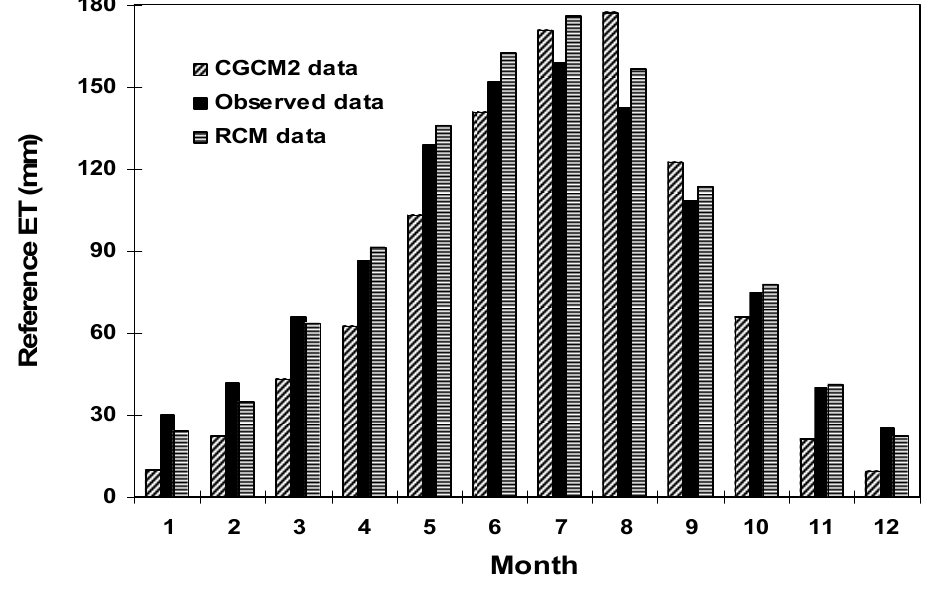
Figure 5. Monthly reference evapotranspiration (ETr) calculated